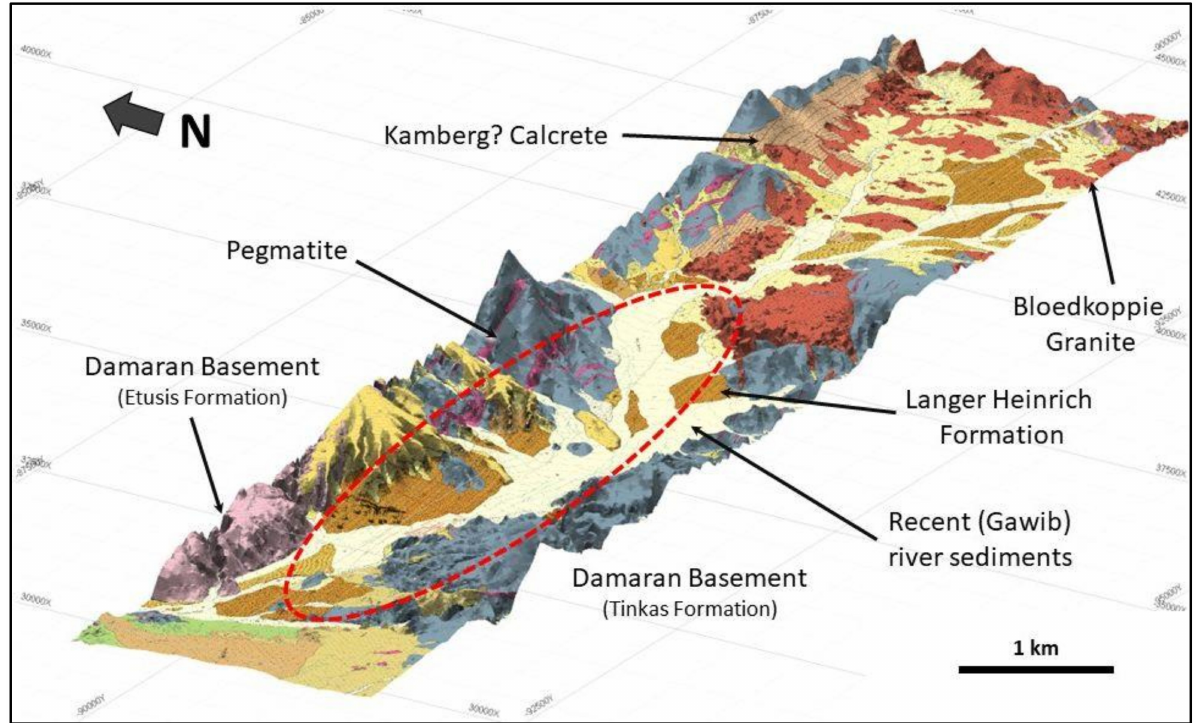
Figure 5. Geology of the Langer Heinrich Valley. Dashed red line is the approximate extent of the mineralised palaeochannel. Geology after [21]. Note ten times vertical